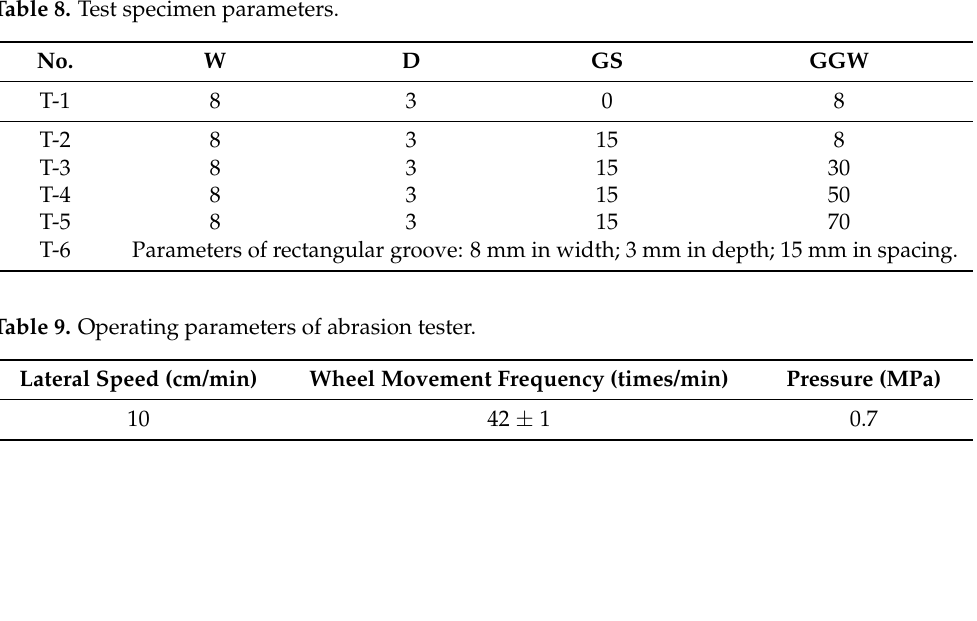
Figure 12. Test specimens and groove size schematic diagram: ( a ) T-1:8-3-0-8; ( b ) T-2:8-3-15-8; ( c ) T-3:8-3-15-30; ( d ) T-4:8-3-15-50; ( e ) T-5:8-3-15-70; ( f ) rectangular groove.